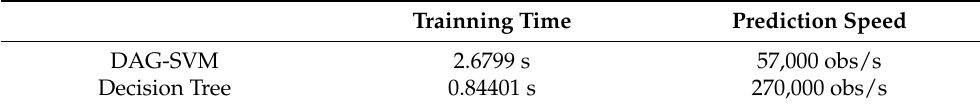
Table 3. Comparison of SVM and decision